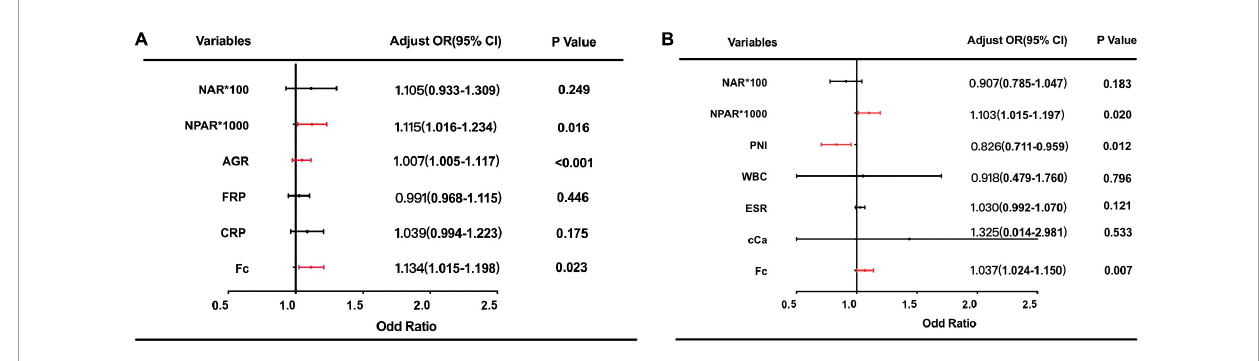
FIGURE3 ORs based on multivariate analyses for prediction of inflammatory bowel diseases (IBD) (A) ; and active clinic stage (B) are exhibited.